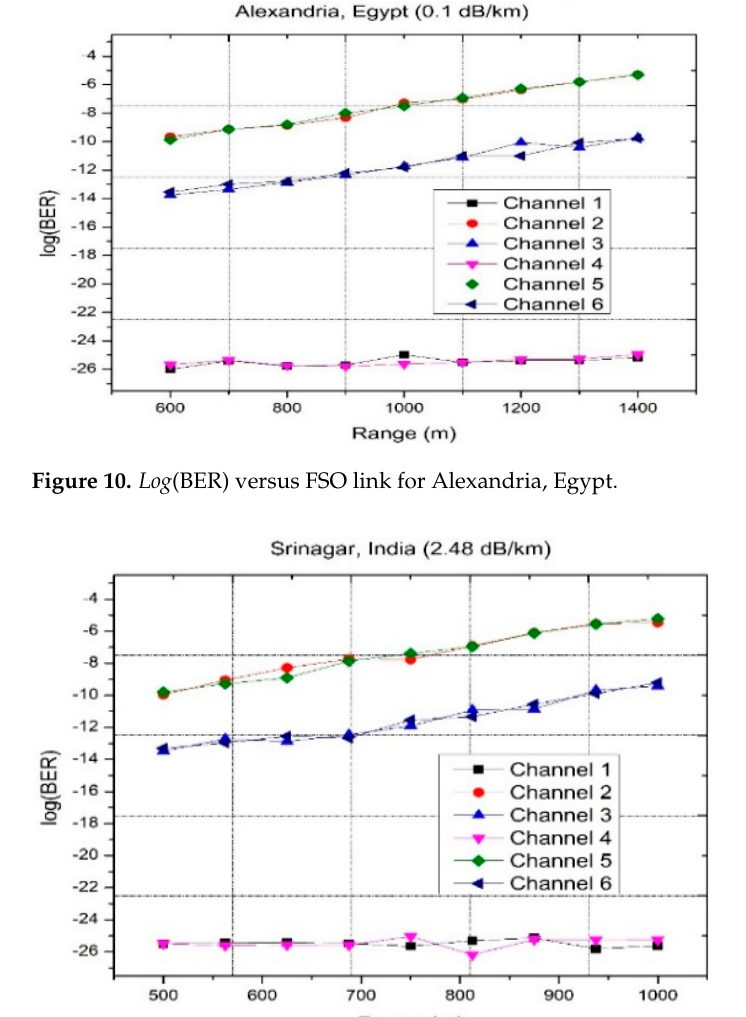
Table 8. Log (BER) values at maximum computed FSO link for our proposed model in Alexandria and Srinagar cities.